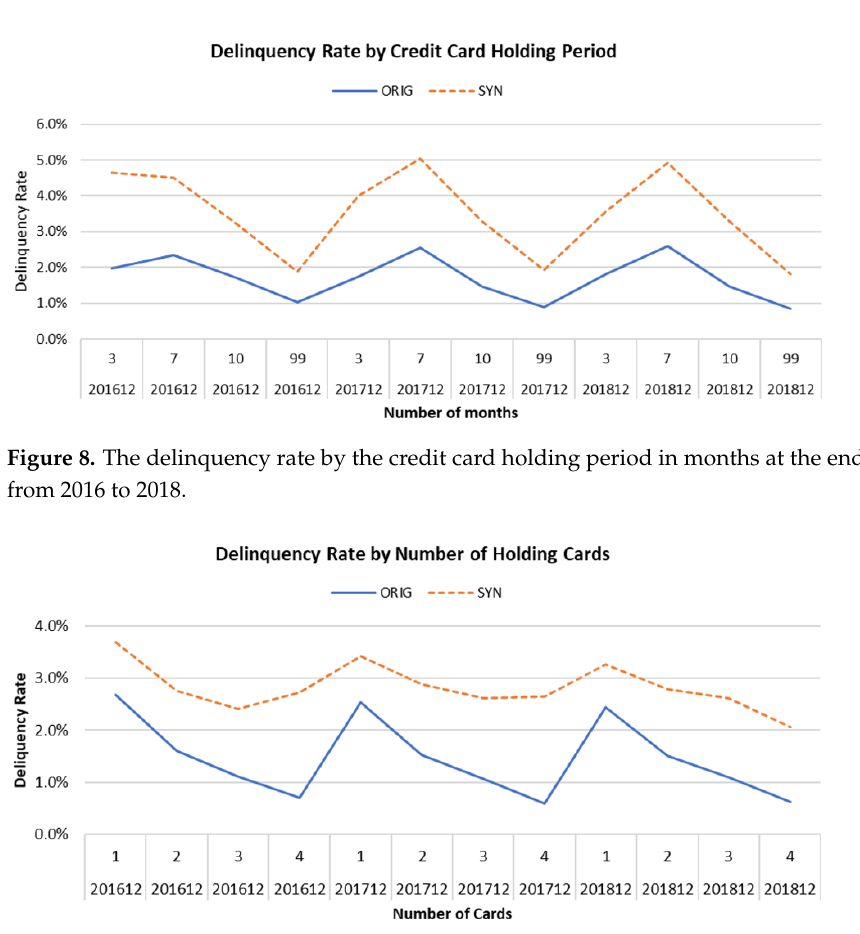
Figure 9. The delinquency rate by the number of holding credit cards at the end of the years from 2016 to 2018.